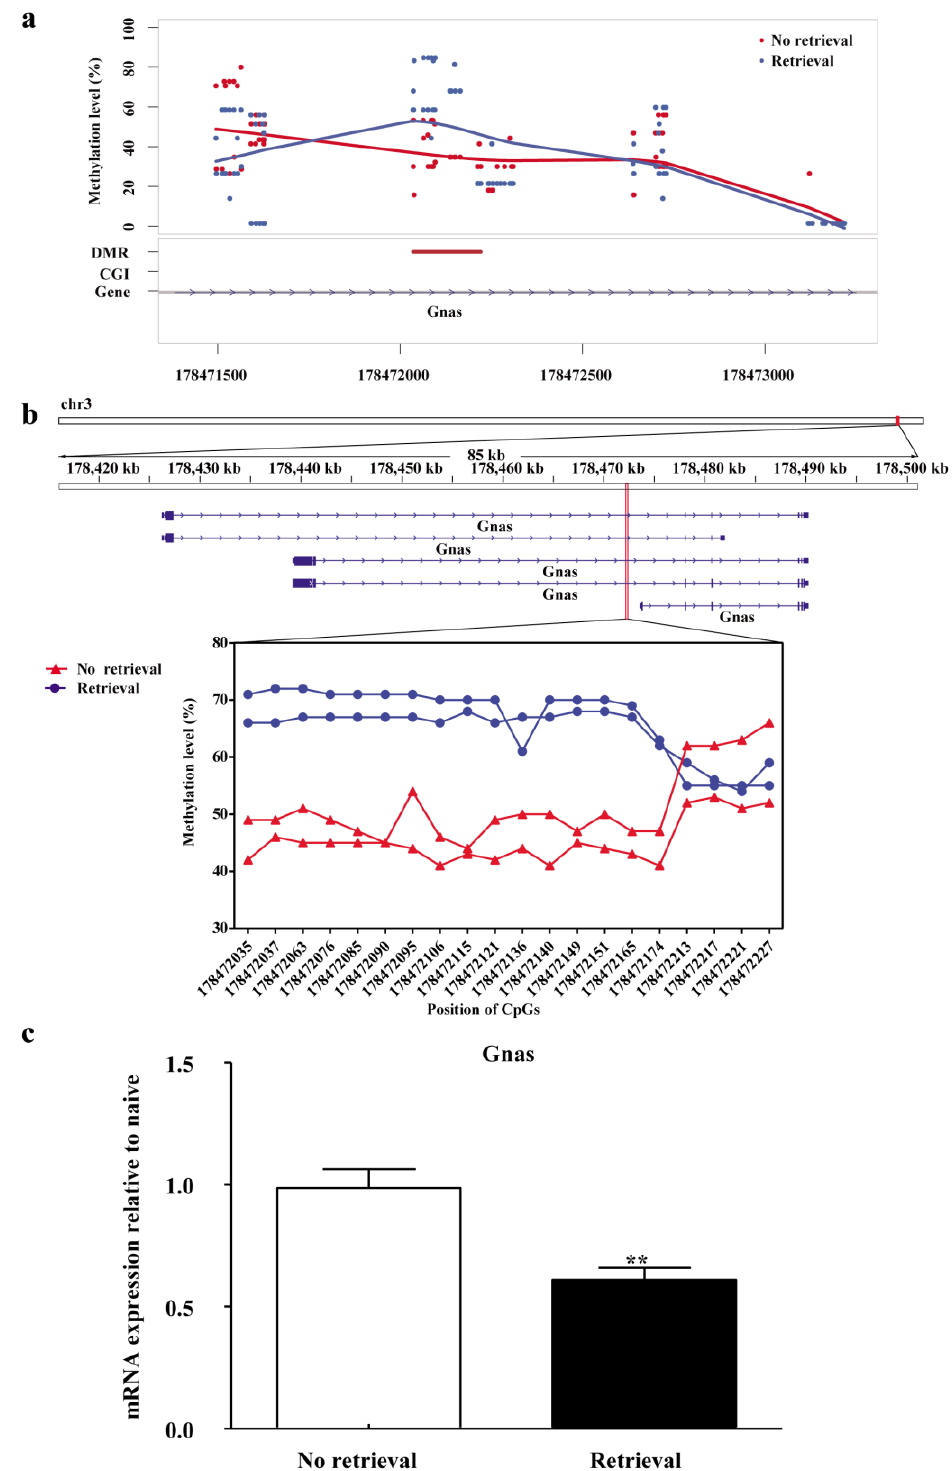
Figure 4. Correlation between DNA methylation and downregulation of mRNA expression at one hour after memory retrieval. ( a ) The DNA methylation level was evaluated by reduced-representation bisulphite sequencing. ( b ) The DNA methylation level was evaluated by bisulphite PCR validation. ( c ) Gene expression level of Gnas after memory retrieval ( n = 4–5). ** p < 0.01, compared to no-retrieval group. The DNA methylation level of Sox10 and Pik3r1 : see Figures S2 and S3.